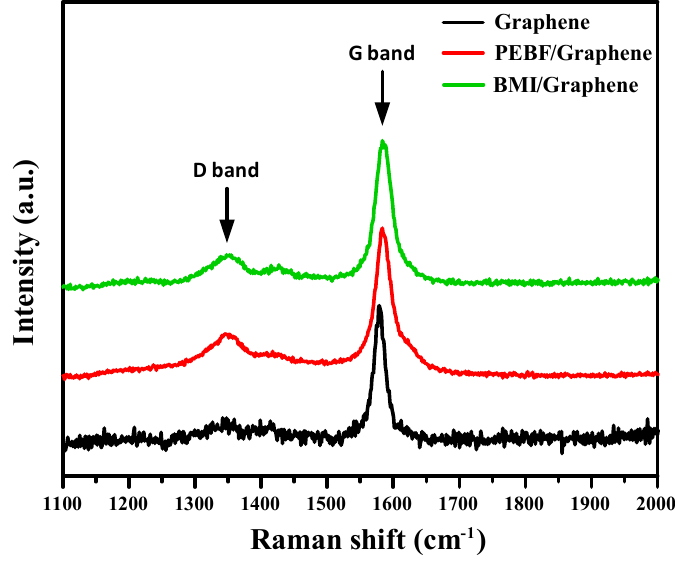
Figure 3. Raman spectra of pristine graphene, PEBF/graphene and 1,1 ′ -(methylenedi-4,1- phenylene)bismaleimide (BMI)/graphene samples.